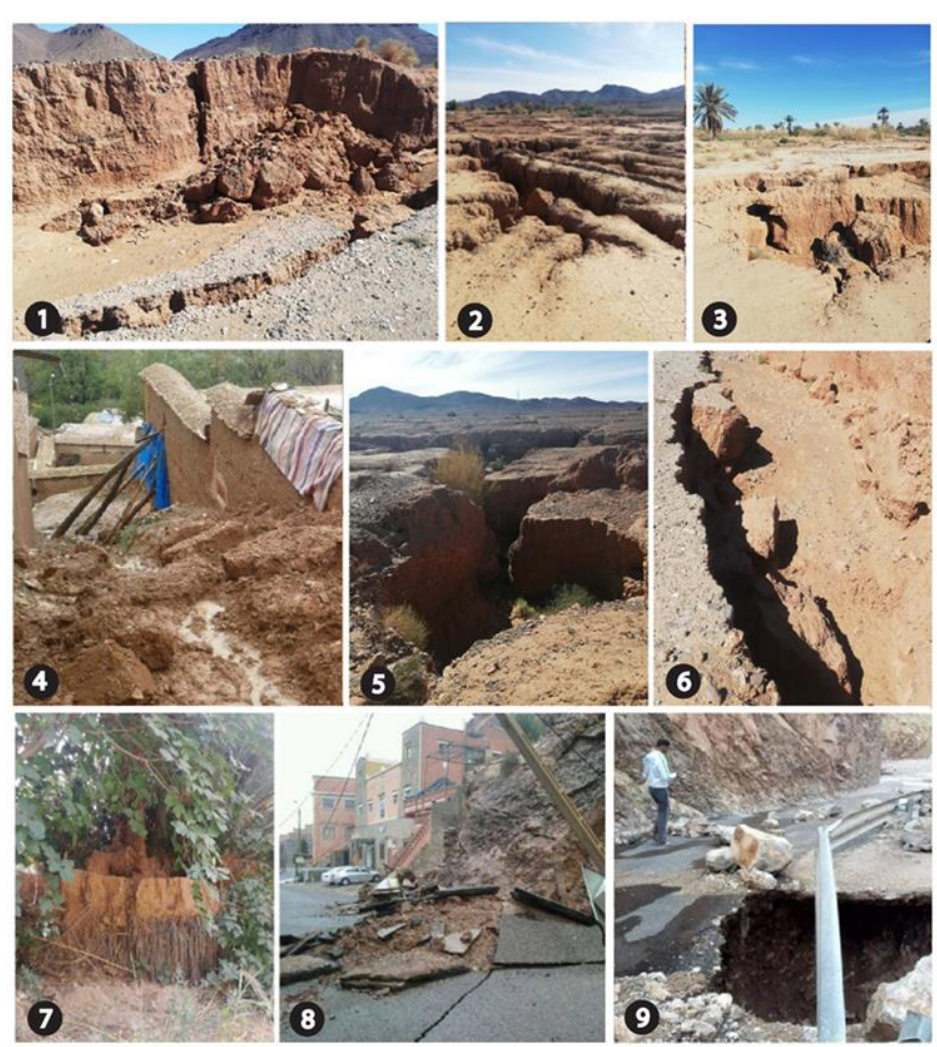
Figure 9. Photographs showing the severity of water erosion and associated floods in the study area: ( 1 ) Taghia, ( 2 ) Taghzout, ( 3 ) Ait Iala, ( 4 ) Ait Hani, ( 5 ) Tilouine, ( 6 ) Taghia, ( 7 ) Asfalou, and ( 8 , 9 ) Tizgui.